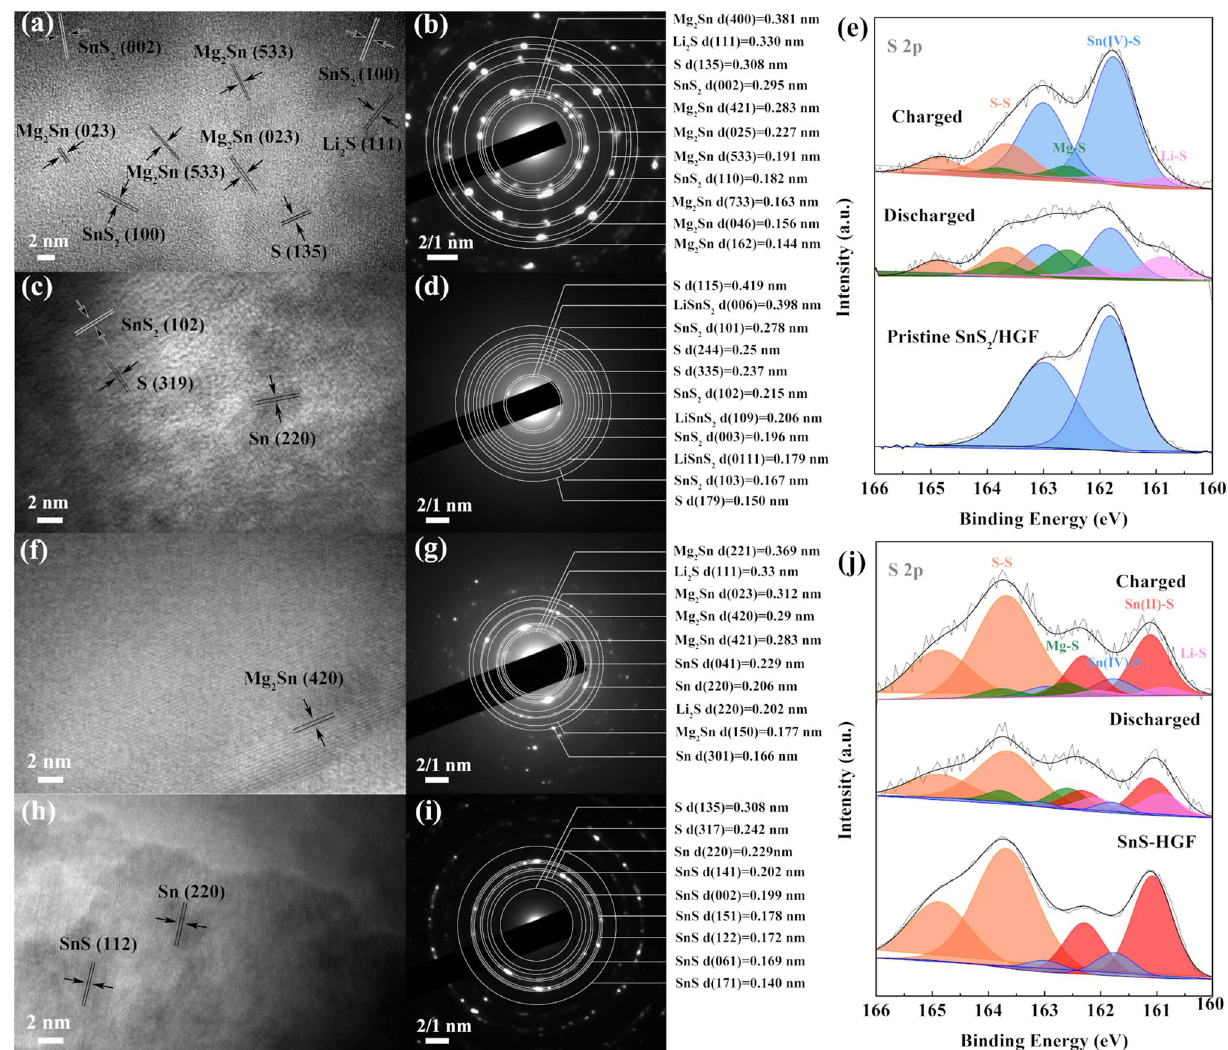
Fig. 7 Ex situ HRTEM images and corresponding SAED pattern in MLHBs. a, b highly defective SnS 2 /HGF and f, g SnS/HGF after fully dis- charged to 0.01 V. c, d highly defective SnS 2 /HGF and h, i SnS/HGF after charged back to 2.0 V. Ex-situ XPS spectra represent valence changes of S 2 p of the e highly defective SnS 2 /HGF and j SnS/HGF after the first cycle at charged and discharged